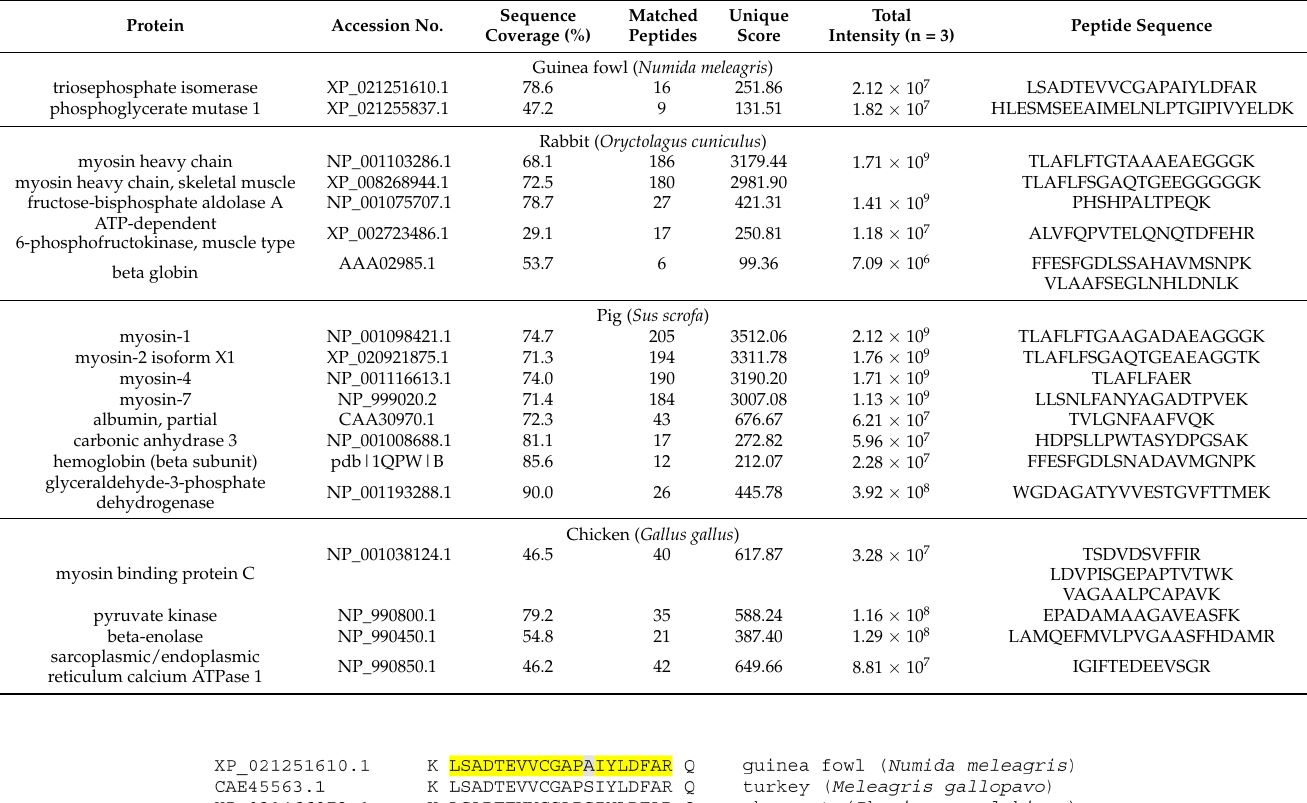
Table 4. Guinea fowl, rabbit, pig, and chicken meat-specific proteins and peptides detected in food products (samples M4 and P12).